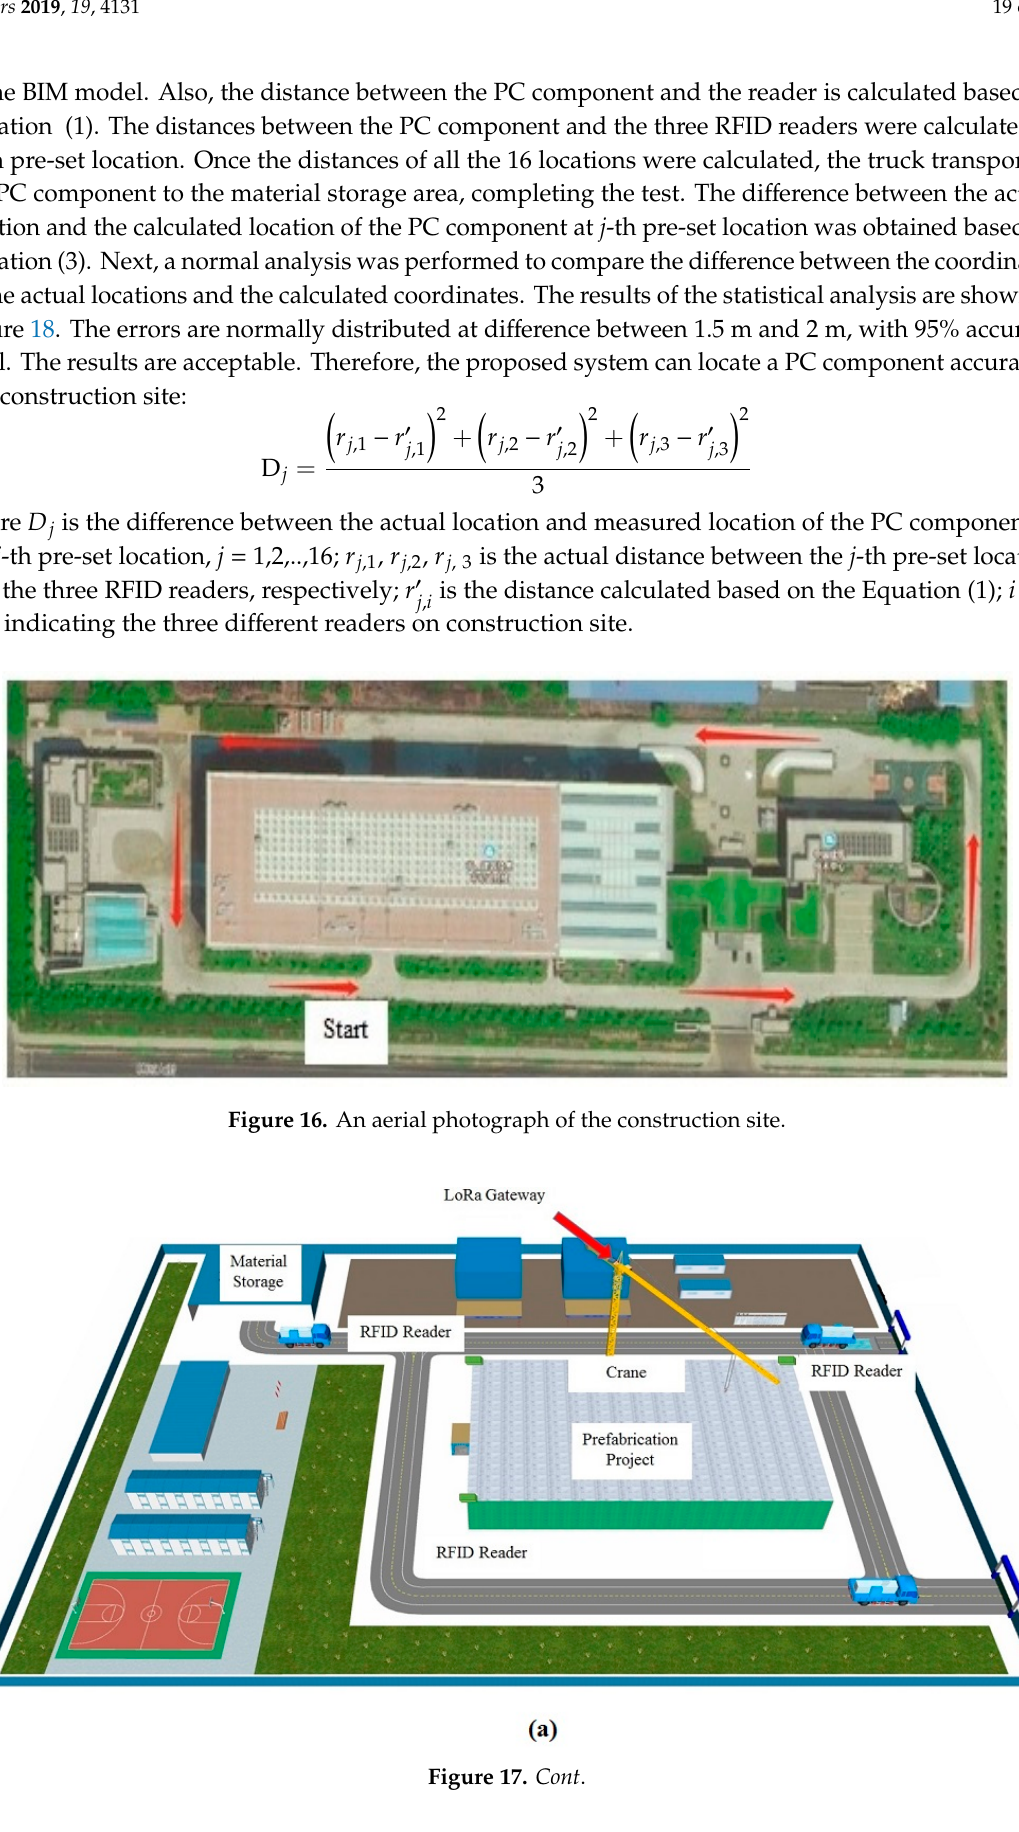
Figure 17. ( a ) The BIM model of the construction site; ( b ) the 16 pre-set locations in the BIM model.